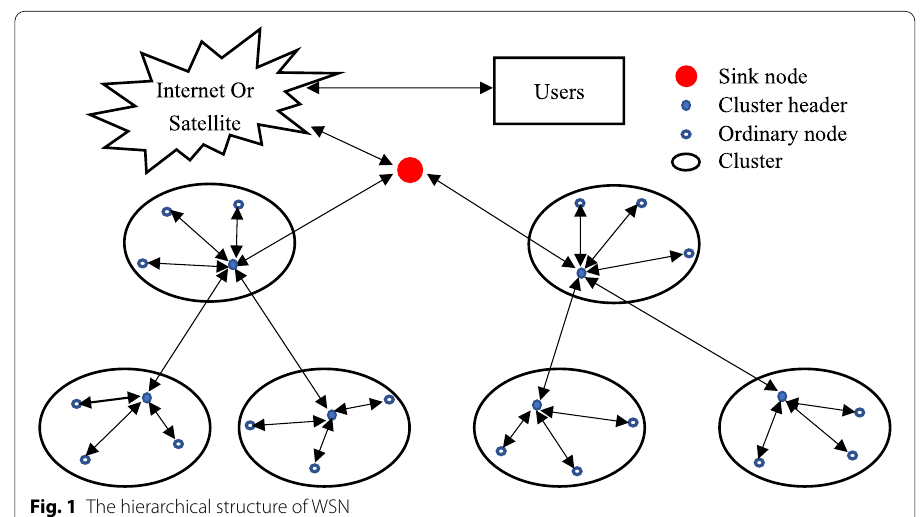
Fig. 1 The hierarchical structure of